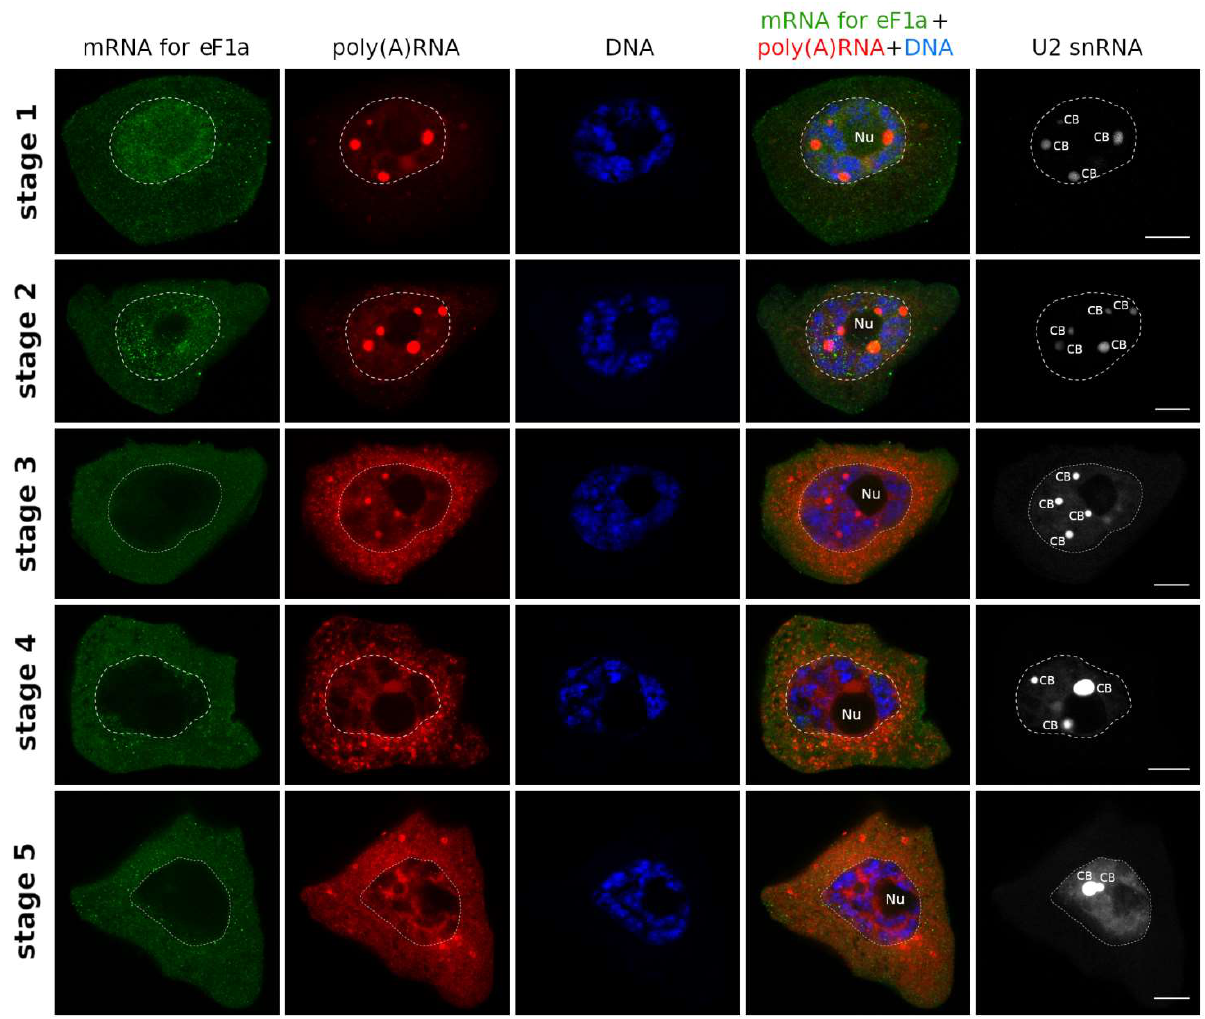
Figure 4. The second pattern of mRNA synthesis and export. Distribution of eF1a mRNA during poly(A) RNA cycle.eF1a mRNA (green) is retained in nucleus until the 2nd stage of poly(A) cycle and is rapidly exported to cytoplasm at the beginning of stage 3. The mRNA is present in cytoplasm until the end of the cycle. Bar—10 μm.